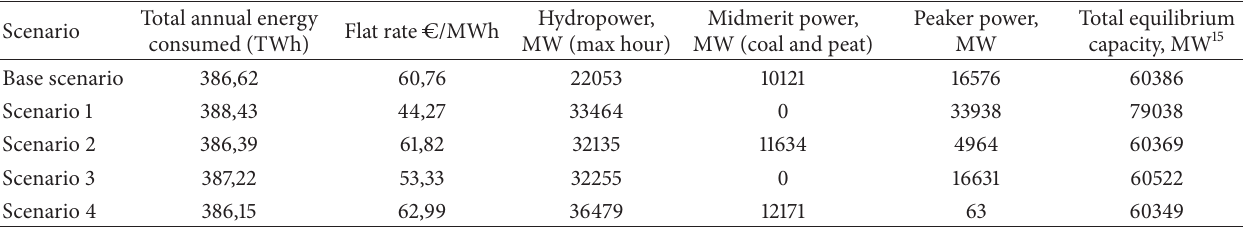
Table 3: Energy consumed, flat rate, and capacities.